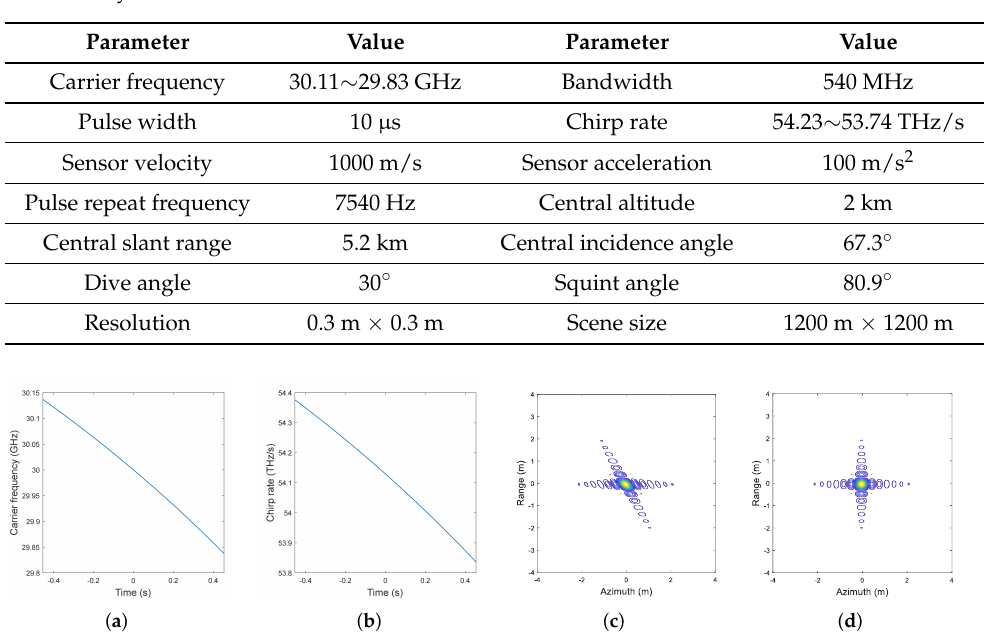
Table 1. Key Simulation Parameters.